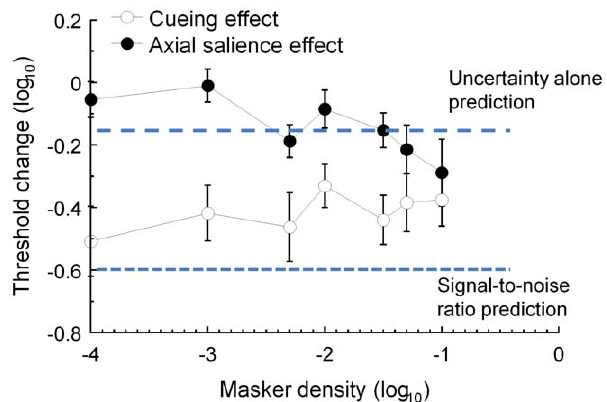
Figure 3. The average threshold change produced by cueing (open circles) and axial salience (closed circles) at different masker densities. The dashed and dotted blue lines indicate the predictions of the uncertainty model and the signal-to-noise, or weight- of-evidence, model respectively.